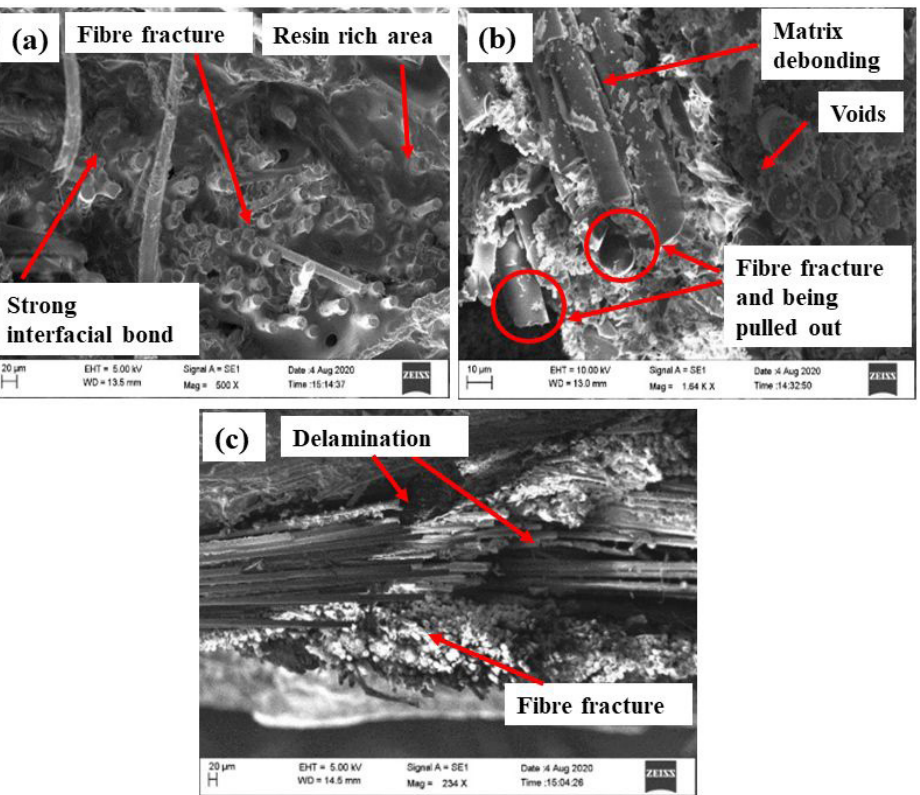
Figure 8. SEM micrographs of fractured tensile test specimens (a) (0 1A /0 3B /0 1A ) specimen (b) (30 1A /0 3B /30 1A ) specimen (c) (45 1A /0 3B /45 1A )